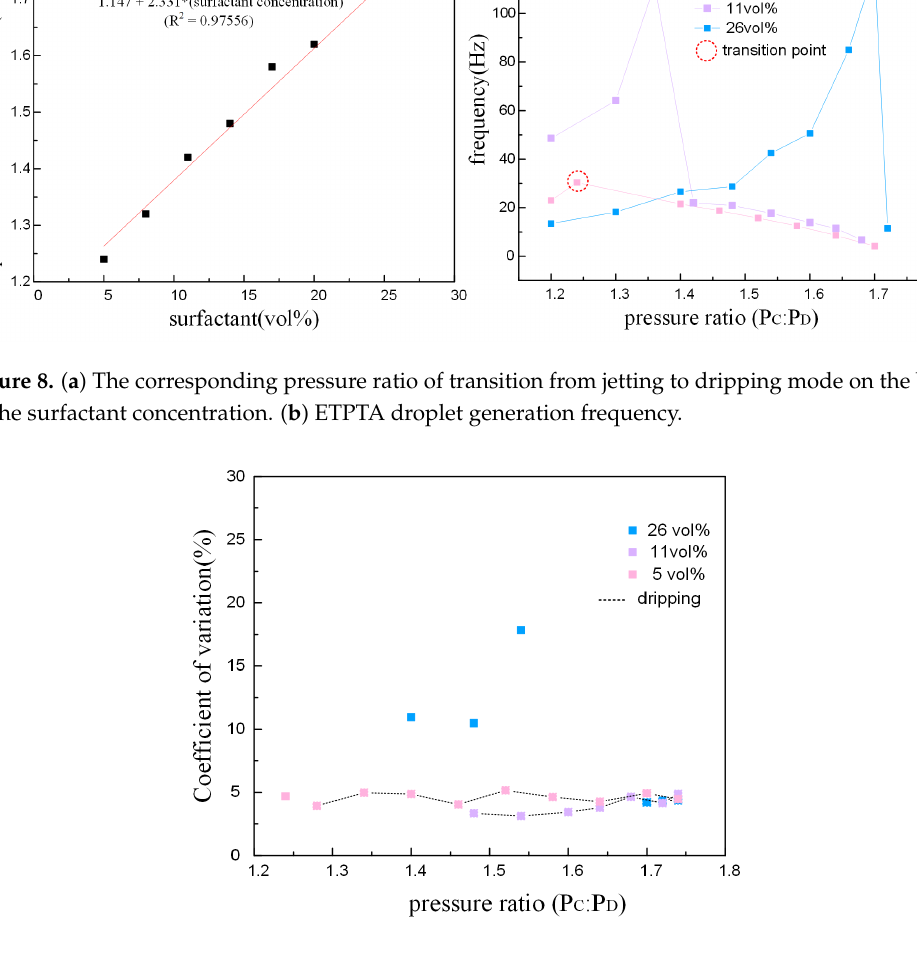
Figure 9. The CV of ETPTA droplets on the basis of pressure ratio and the bulk concentration of surfactant. CV = standard deviation/mean.